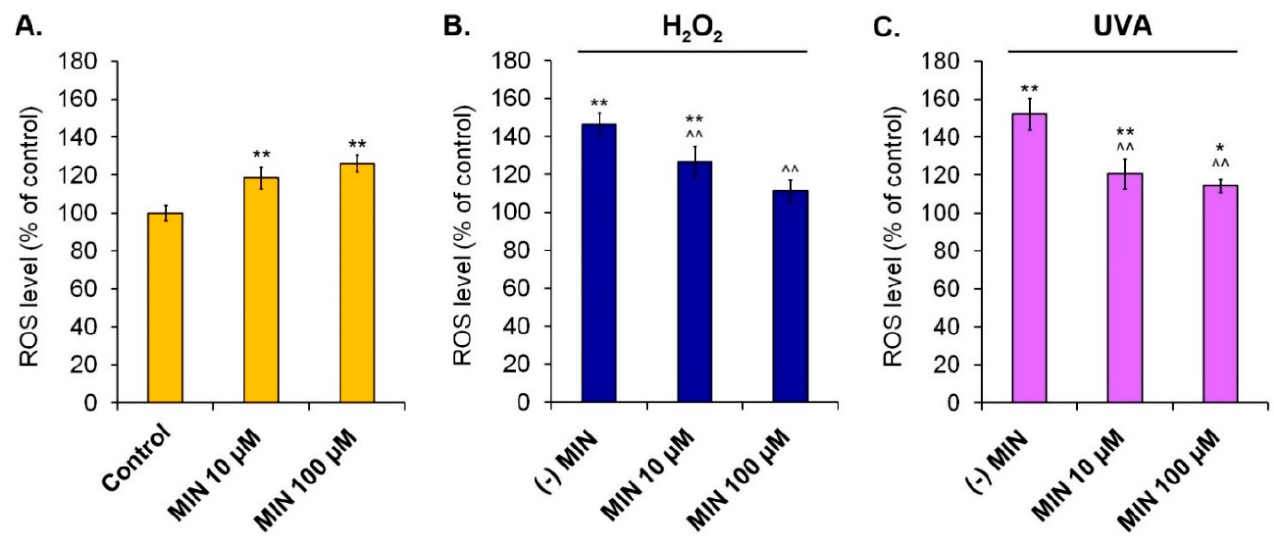
Figure 4. The influence of minocycline on intracellular reactive oxygen species (ROS) level in human normal melanocytes ( A ) as well as melanocytes additionally exposed to hydrogen peroxide ( B ) or irradiated with UVA ( C ). * p < 0.05, ** p < 0.005 vs. control; ˆˆ p < 0.005. vs. (-) MIN.